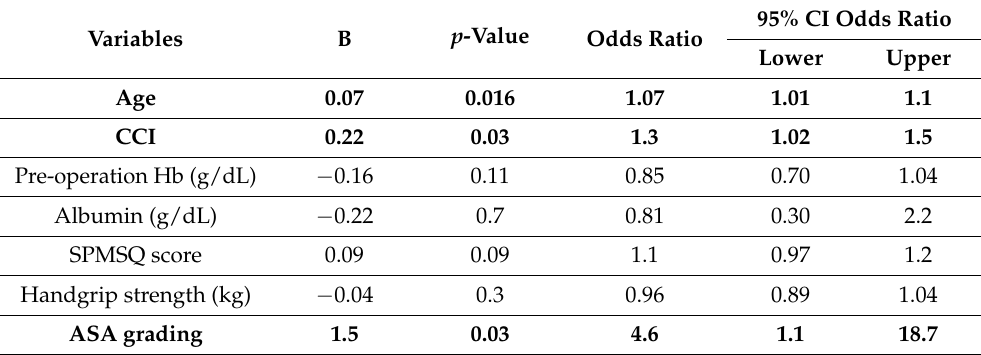
Table 2. Multiple logistic regression model of factors affecting postoperative 1-year mortality in older adults with hip fracture.